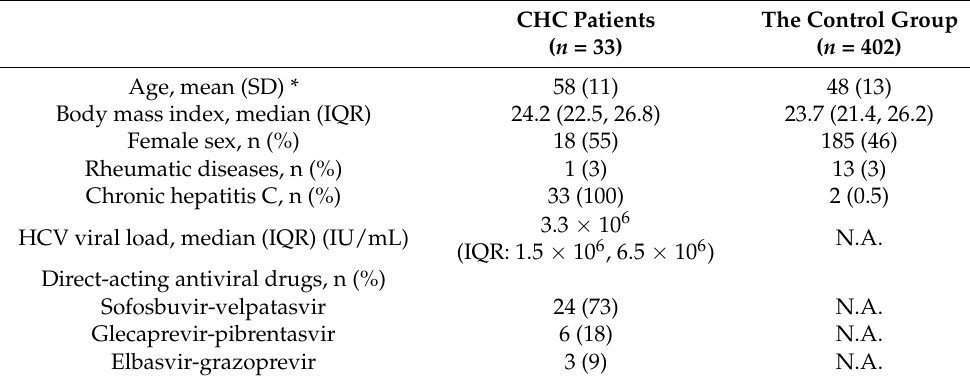
Table 1. Baseline characteristics of study participants.